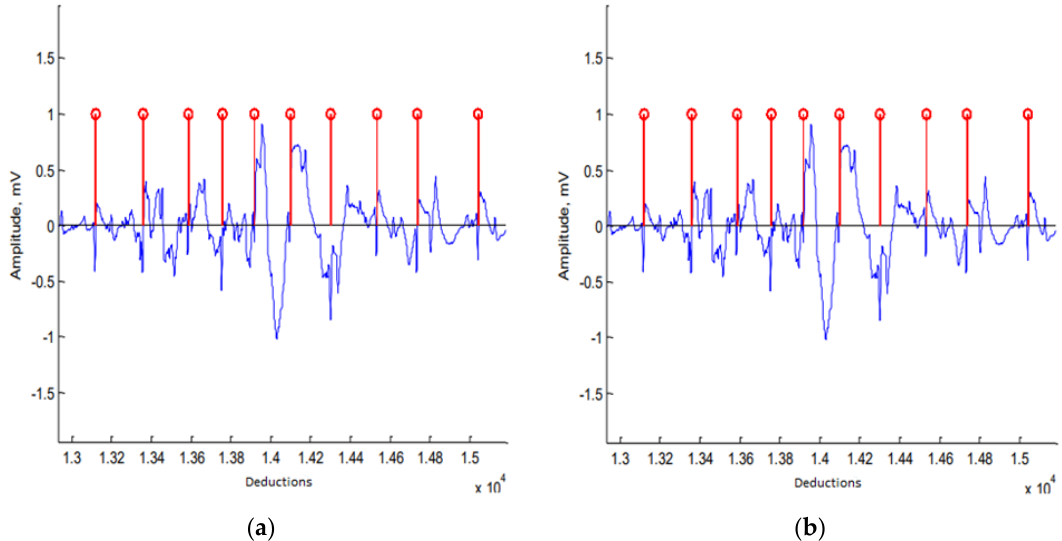
Figure 1. The registered electrocardiogram (ECG) and breathing signals and algorithms according to the maximum systole moments determined using the derivative value ( a ) and algorithm-detected expiration moments ( b ).